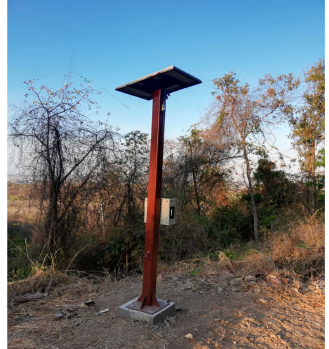
Figure 2. Autonomous stations of 50 W. Sendero “Mirador” Escuela Superior Polit é cnica del Litoral